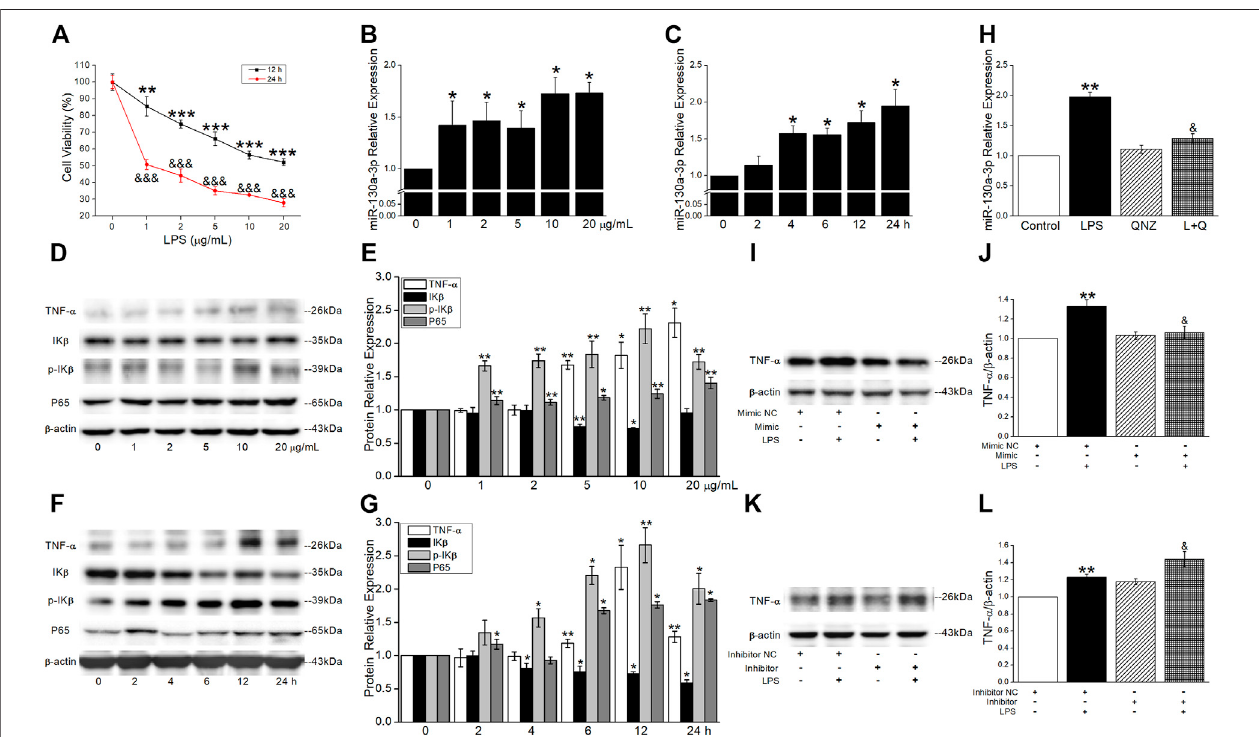
FIGURE7| MiR-130a-3psuppressesTNF- α productioninthein fl ammatoryphase. (A) RelativecellviabilitywasmeasuredbyCCK-8assay,andthedatafor0 μ g/ ml wereset to100%. ** p < 0.01, *** p < 0.001,versus0 μ g/ml (12 h); &&& p < 0.001, versus0 μ g/ml (24 h),one-wayANOVA followed byBonferroni ’ stest, n =3 – 4. (B-C) qRT-PCR quantitation of miR-130a-3p expression under concentration- and time-dependent LPS treatment. * p < 0.05, versus 0 μ g/ml or 0 h, by the Mann – Whitney U test, n = 4. Representative and statistical data of NF- κ B signal pathway protein levels under (D-E) concentration- and (F-G) time-dependent LPS treatment. p < 0.05,** p < 0.01,versus0 μ g/mlor0 h,bytheMann – Whitney U test, n =3 – 5.MH-Scellsweretreatedwith11 nMofNF- κ Binhibitor(QNZ)and10 μ g/mlofLPSfor12 h. (H) qRT-PCR quantitation of miR-130a-3p expression. ** p < 0.01, versus the control group; & p < 0.05, versus the LPS group, by the Mann – Whitney U test, n = 4. (I-J) Representative and statistical dataofTNF- α proteinafter LPSadministration and/or miR-130a-3p mimic transfection. (K-L) Representative and statistical dataofTNF- α protein after LPS administration and/or miR-130a-3p inhibitor transfection. ** p < 0.01, versus the Mimic/Inhibitor NC group; & p < 0.05, versus the Mimic/Inhibitor NC + LPS group, by the Mann – Whitney U test, n =